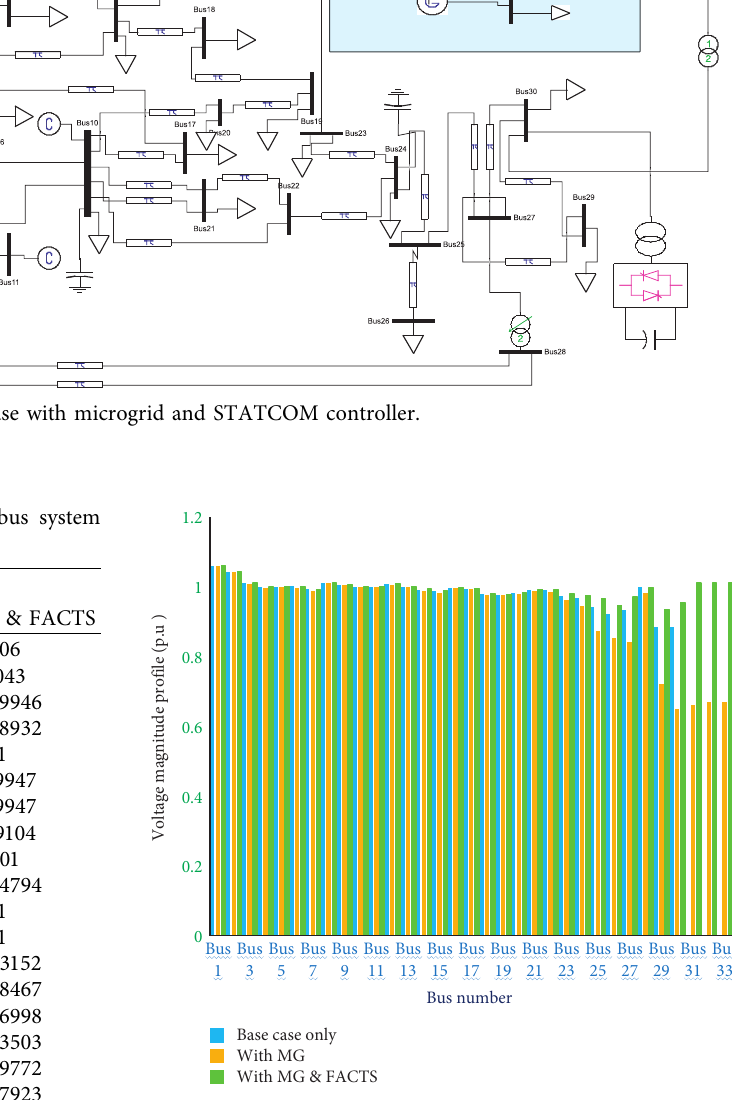
Figure 11: Base case, with microgrid, and STATCOM